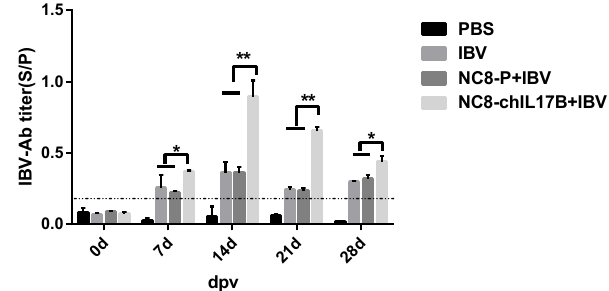
Figure 3. IBV-specific antibodies in the serum. The antibody titers are shown as mean sample vs. positive control (S/P) values + S.D. of each group. The threshold cut-off values of the IBV ELISA were 0.2. S ÷ P = (Sample A (650) − NC A (650)) ÷ (PC A (650) − NC A (650)). Tukey’s multiple comparison test was used for statistical analysis; * p < 0.05, ** p < 0.01 .